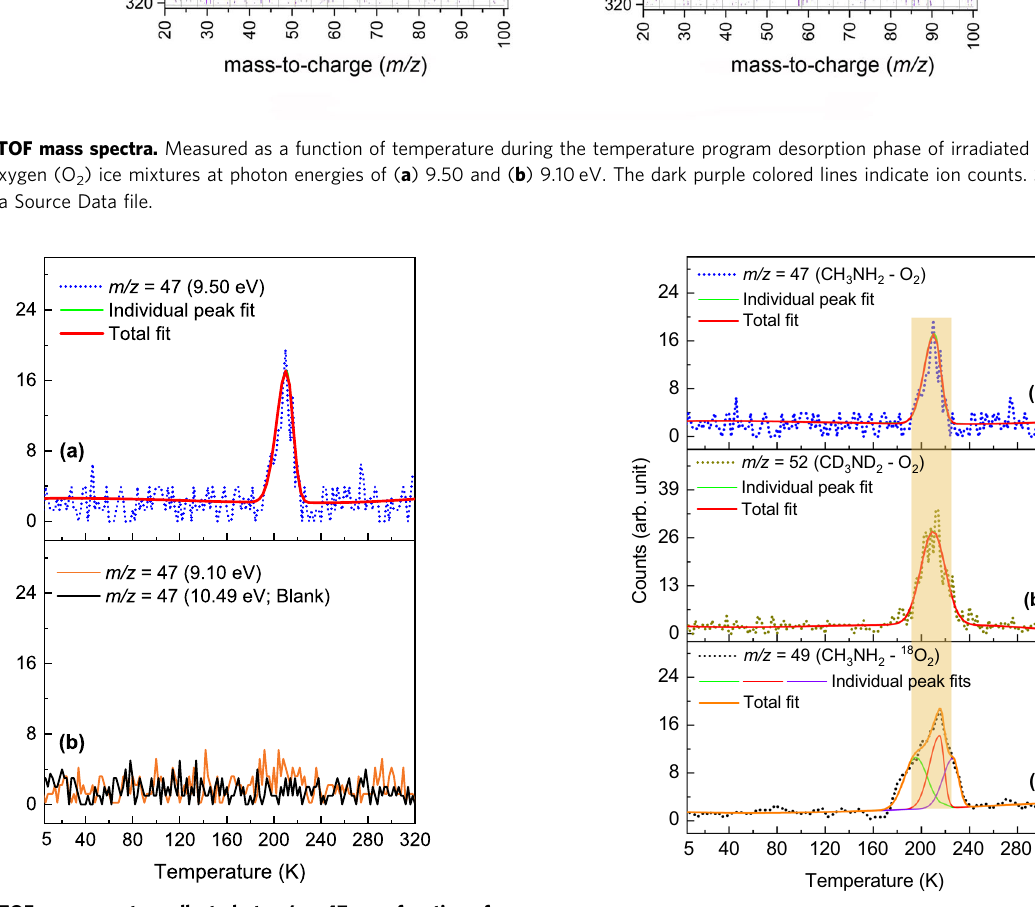
Fig. 5 PI-ReTOF mass spectra collected in isotopic experiments at a photon energy of 9.50 eV. ( a ), ( b ), and ( c ) are temperature program desorption (TPD) pro fi les obtained at m/z = 47, 52, and 49 during the sublimation phase of irradiated CH 3 NH 2 – O 2 , CD 3 ND 2 – O 2 , and CH 3 NH 2 – 18 O 2 ice mixtures, respectively. The shaded region indicates the peak corresponding to the target molecule, aminomethanol. Source data are provided as a Source Data fi